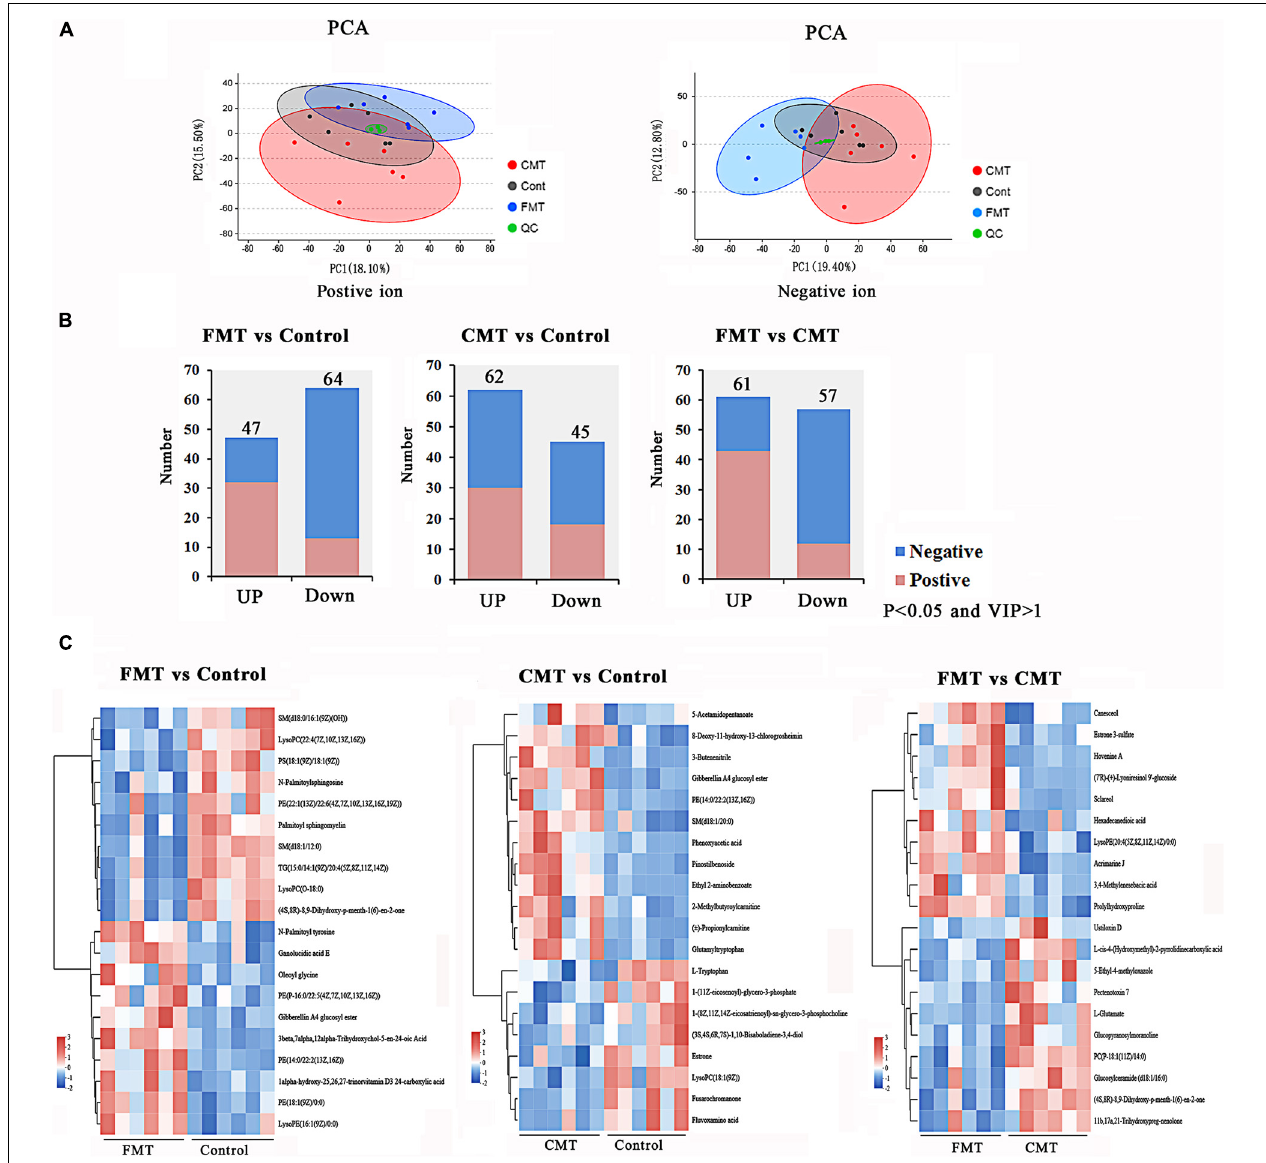
FIGURE 7 | Microbiota transplantation affected the blood metabolome in piglets. (A) Principal component analysis (PCA) based on positive and negative blood metabolite profiles. (B) The number of differentially expressed metabolites with functional annotations ( P < 0.05 and VIP > 1) in the three groups of piglets. (C) Heatmap demonstrating significantly different metabolites (top 20). Red indicates high abundance, and blue indicates low abundance.